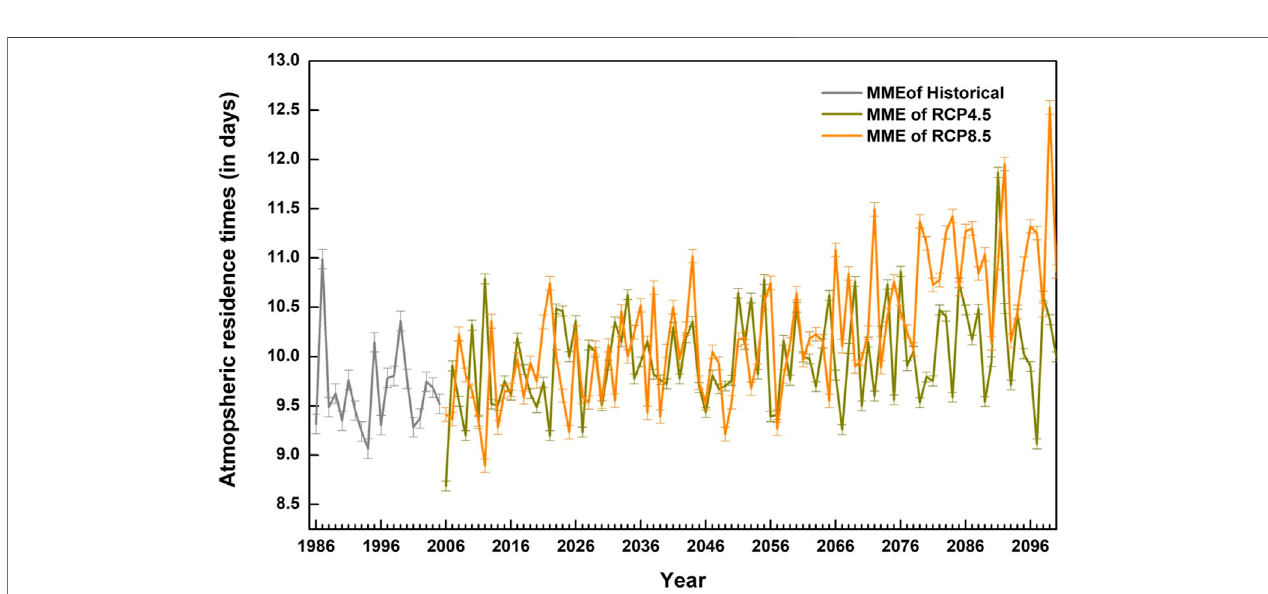
FIGURE2| MeanmonthlyatmosphericresidencetimesoverIndianlandmassfortheSWmonsoonfrom1986to2,100obtainedfromthemultimodelensembleof CMIP 5 (vertical bars represent the standard error from the 19 global climate models).